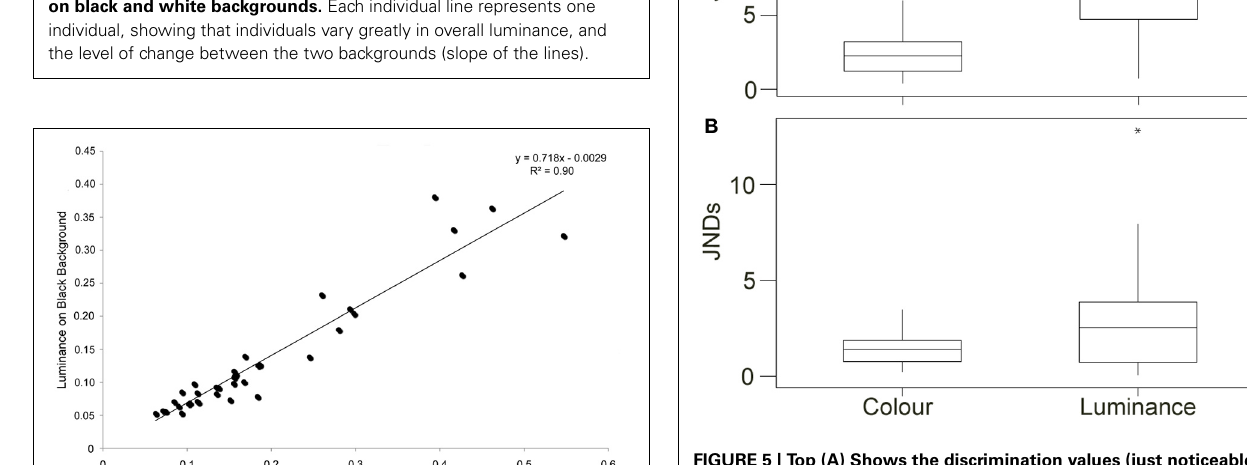
FIGURE 5 | Top (A) Shows the discrimination values (just noticeable differences; JNDs) for color and luminance of the crabs when comparing values for crabs on the white and black backgrounds in experiment 1 [main boxes show medians plus inter-quartile range (IQR), whiskers are lowest and highest values that are within 1.5 ∗ IQR from the upper and lower quartiles, asterisks represent outliers]. (B) Shows the same results when comparing crabs in experiment 2 on red and green